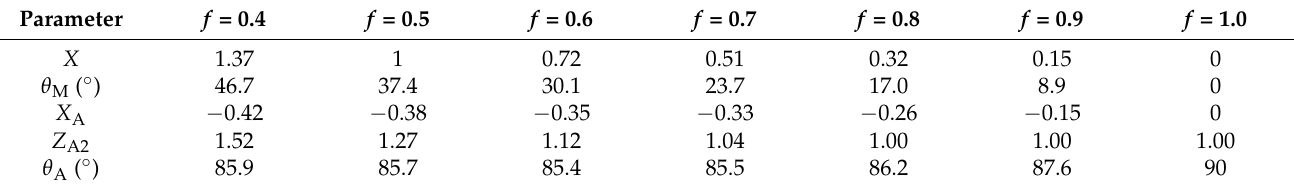
Table 2. The values of the corresponding